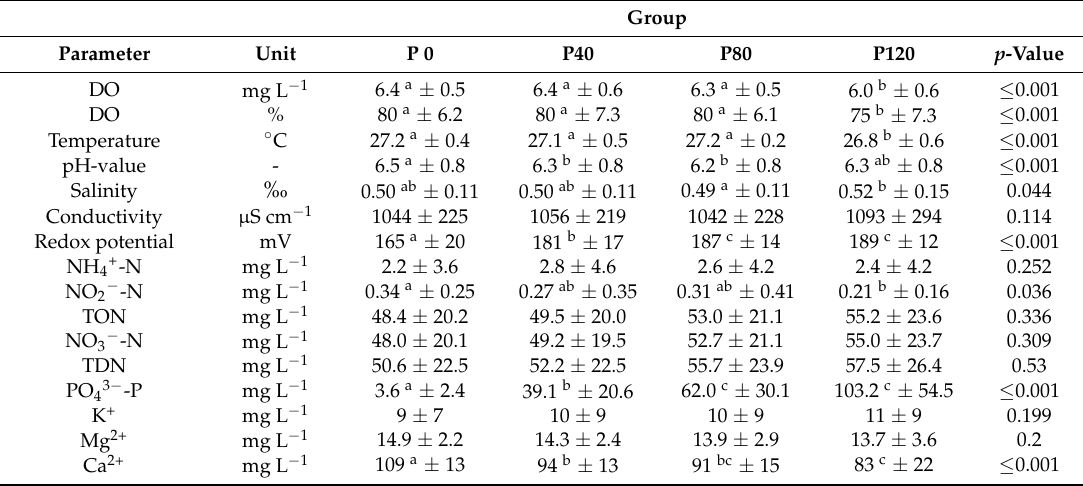
Table 1. Water quality parameters (mean ± standard deviation (SD)).